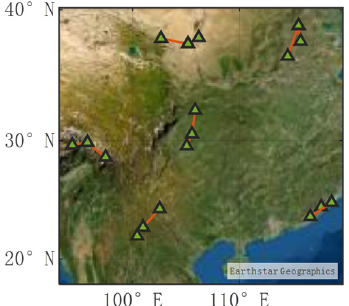
Figure 4. Distribution of 12 link locations in 6 regions. Table 1. Location parameters of 12 links in 6 regions.